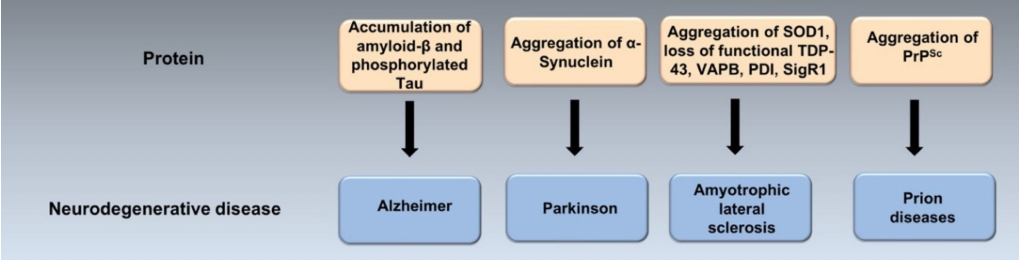
Figure 3. Protein misfolding and aggregation in the pathogenesis of neurodegenerative diseases. The accumulation of misfolded and aggregated particular proteins may play a crucial role in